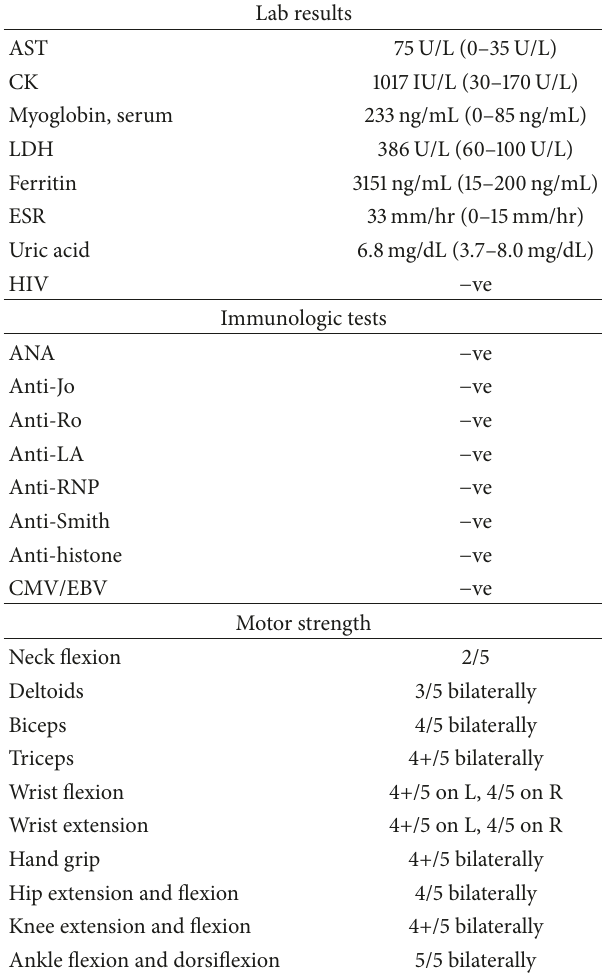
Table 1: A summary of the significant lab results, immunologic test results, and results from the detailed motor strength